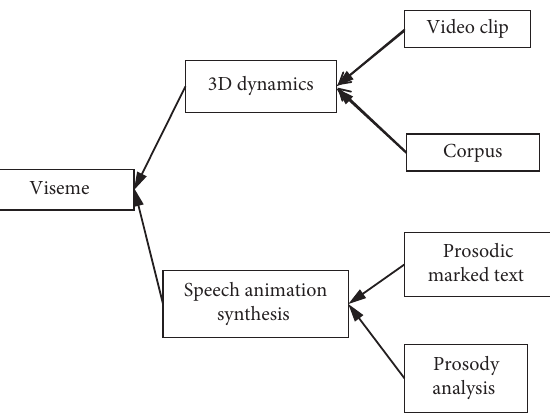
Figure 1: Frame diagram of the lip sync animation.